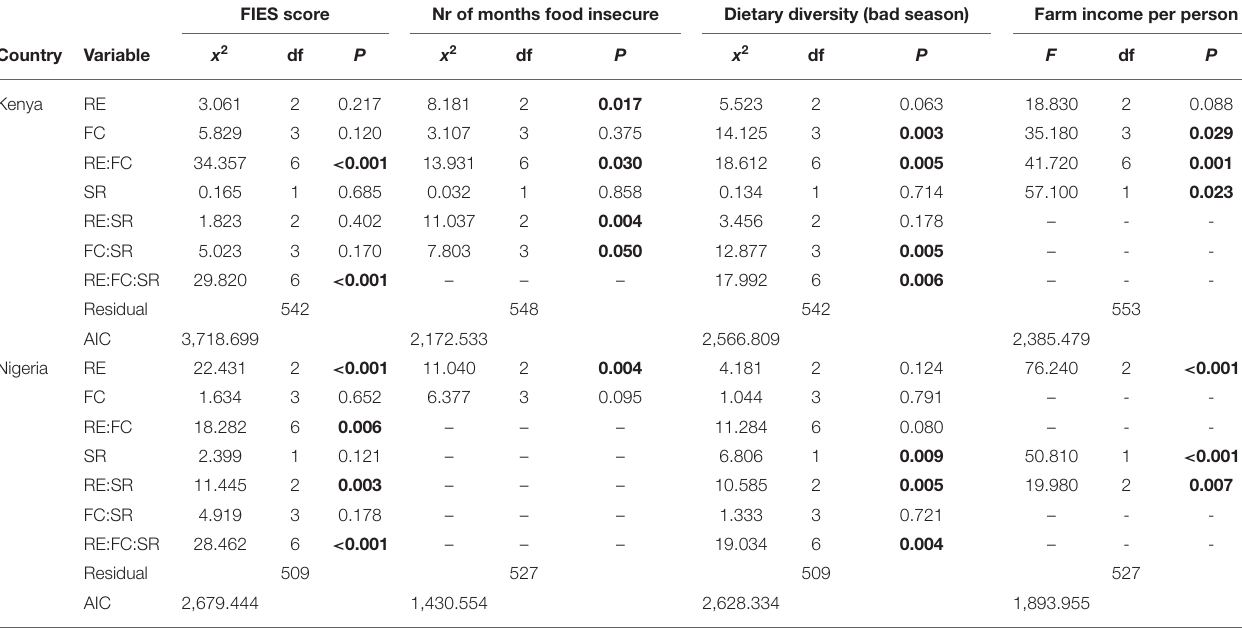
TABLE 5 | Model fitting results showing the fitted effects of RE and FC groups and species richness for the four livelihood outcome indicators, for the final reduced models. FIES score Nr of months food insecure Dietary diversity (bad season) Farm income per